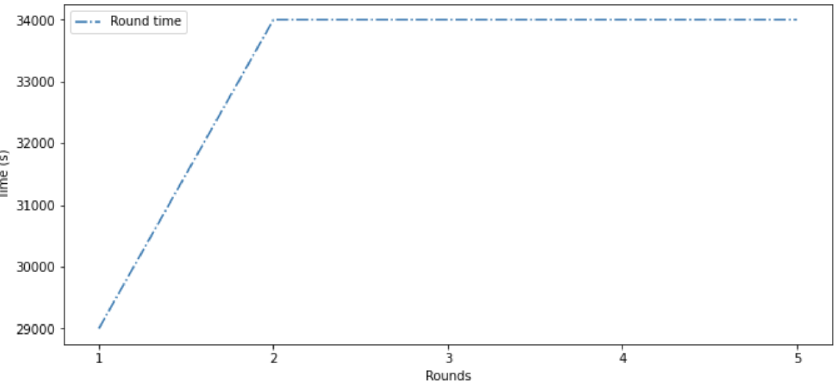
Figure 7. Round times for global model training (FEDn network).